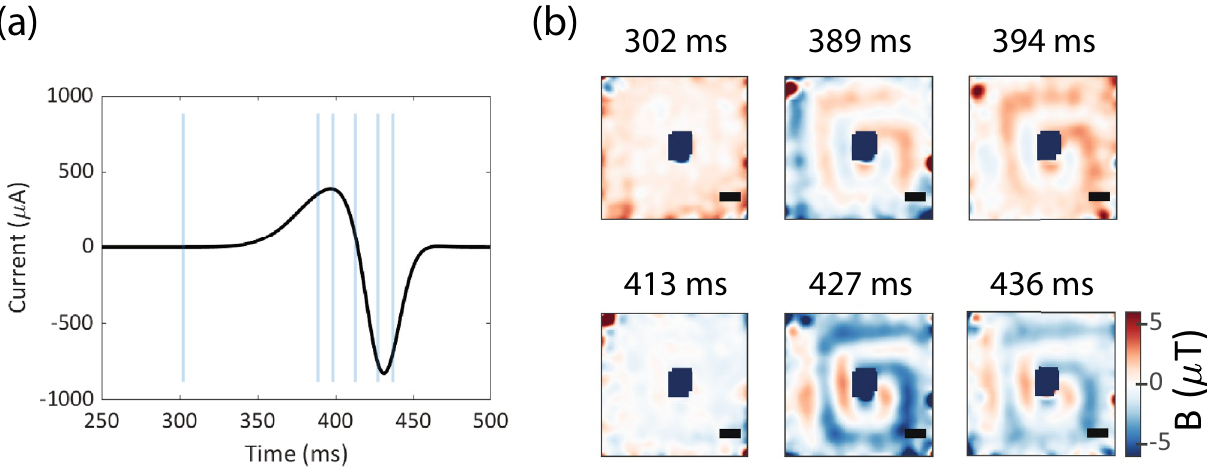
Figure 7. Temporal imaging of an arbitrary millisecond scale magnetic field variation at 208 frames per second of the microcoil sample: ( a ) applied current profile to the microcoil sample. The main waveform signature lasts for less than 150 ms. Vertical blue lines indicates time-points where single magnetic field image frames have been shown further. ( b ) Example magnetic field frames at selected time-points (averaged n have been shown. Magnetic field images are Gaussian-smoothened with 4.5 σ filter. The applied current profile